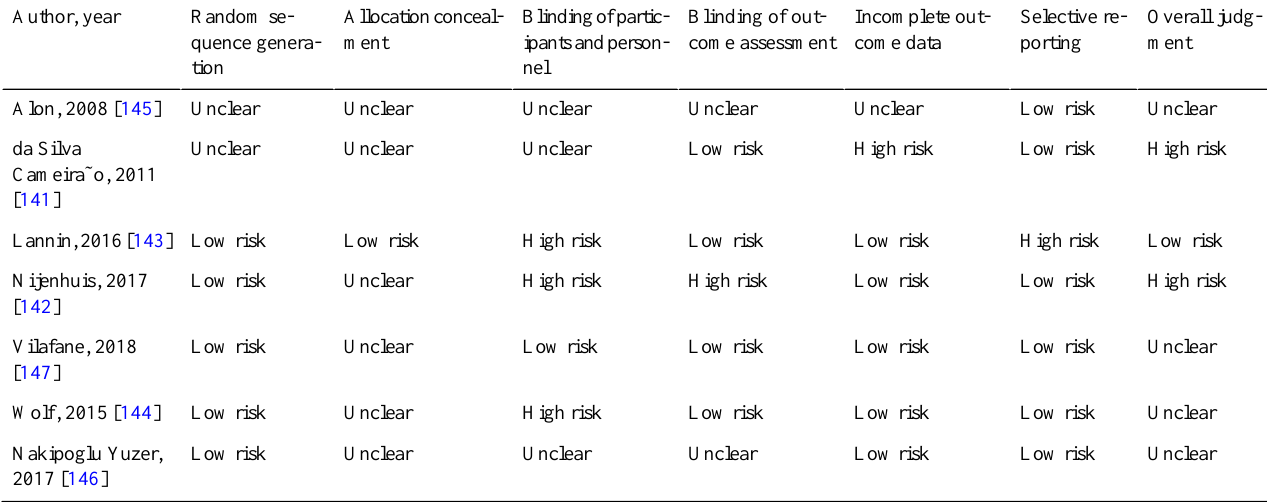
Table 1. Cochrane risk of bias quality assessment